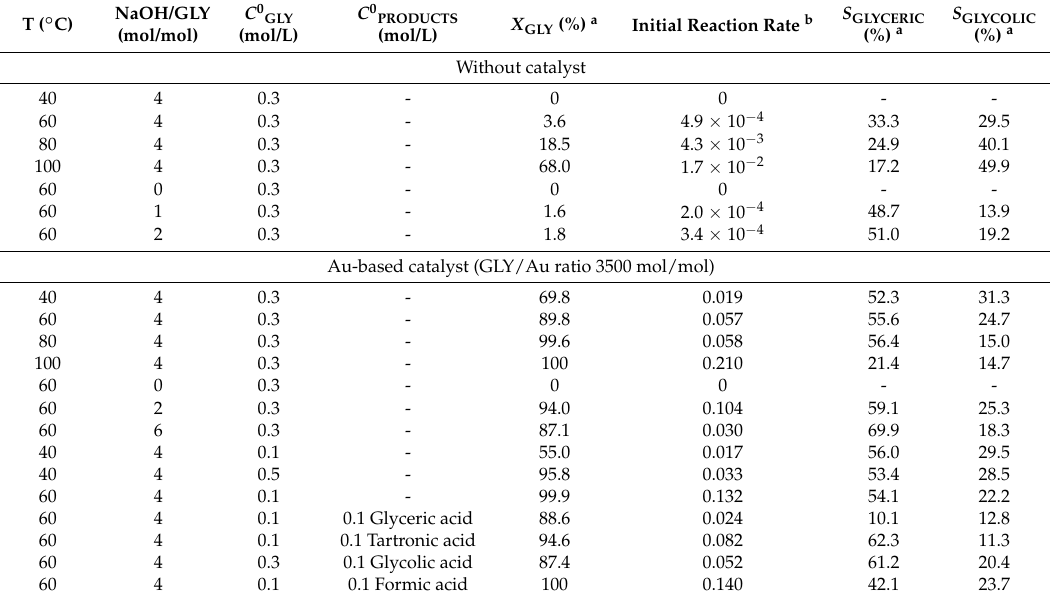
Table 1. Experimental results obtained at different reaction conditions (pO 2 5 bar, stirring speed 1500 rpm).